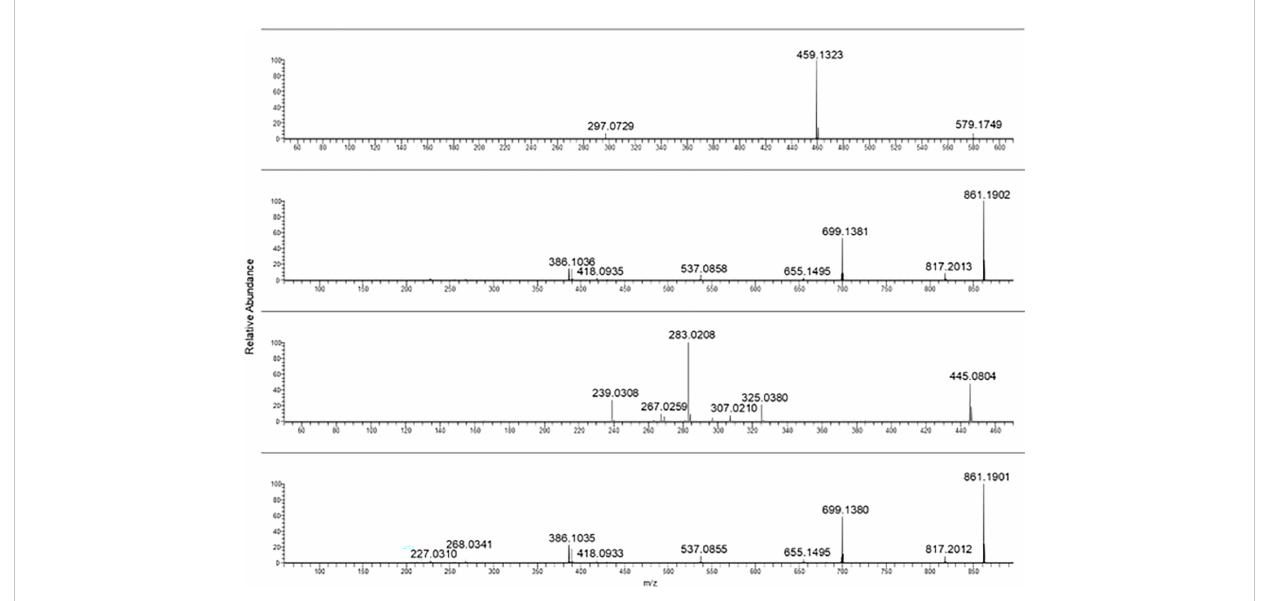
FIGURE 1 From top to bottom: cascaroside A, sennoside B, rhein-8-glucoside, and sennoside A MS/MS spectra.